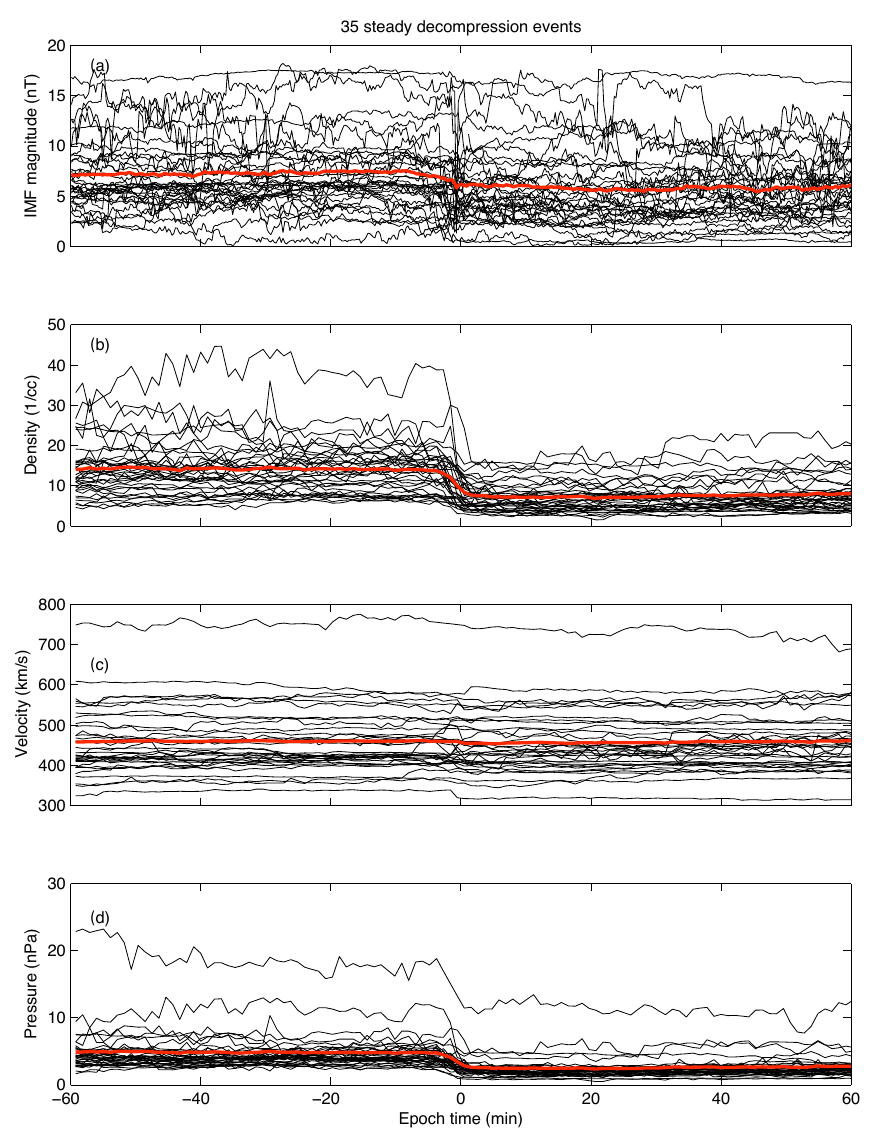
Fig. 3. Individual events (black) and the superposed epoch average (red) for the 35 steady decompression events with a simultaneous decrease or relatively steady IMF magnitude. (a) IMF magnitude, (b) solar wind density, (c) solar wind velocity, and (d) solar wind dynamics